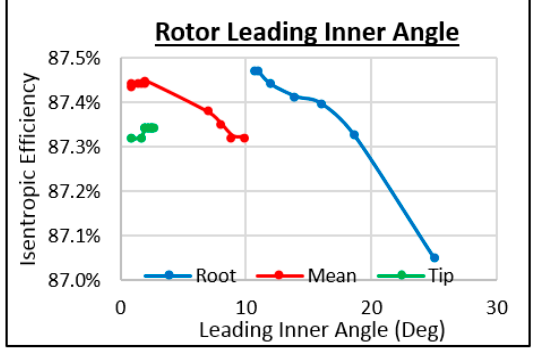
Figure 31. Study of the rotor leading inner angle.